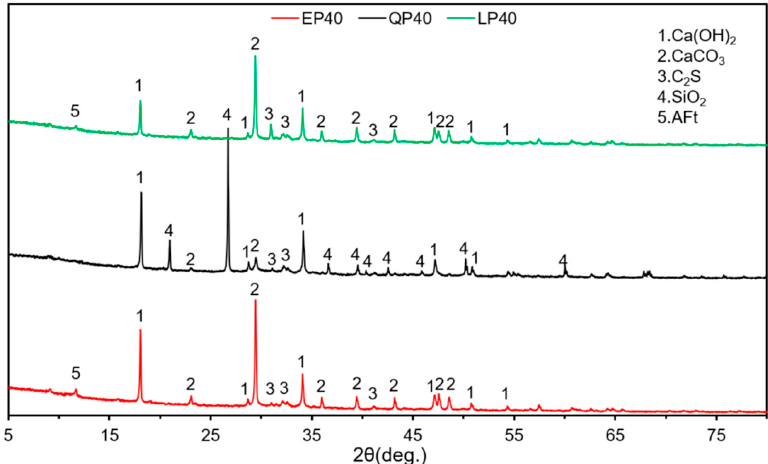
Figure 13. X-ray diffraction (XRD) analysis of EP40, QP40 and LP40 at 28 d.